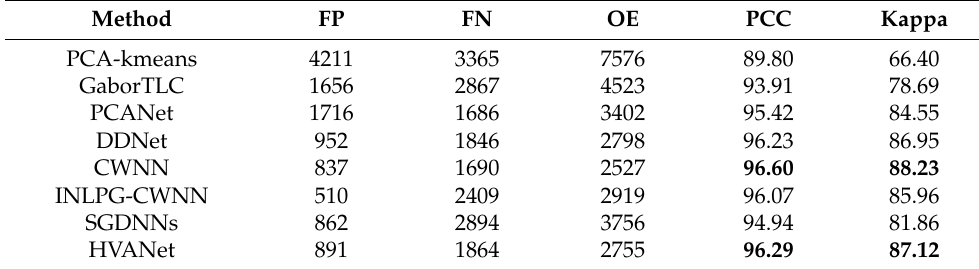
Figure 10. Ground truth and change maps by different methods for the Ottawa dataset. ( a ) PCA- kmeans, ( b ) GaborTLC, ( c ) PCANet, ( d ) DDNet, ( e ) CWNN, ( f ) INLPG-CWNN, ( g ) SGDNNs, ( h ) HVANet, ( i ) ground truth. Table 9. Change detection results of each method on Farmland A